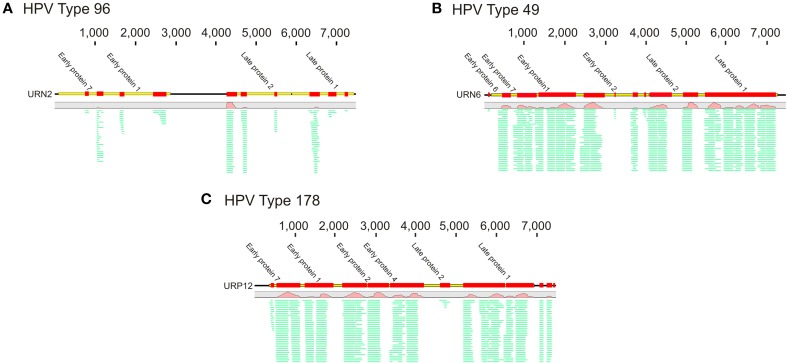
Read mappings of select viromes to Human papillomaviruses (HPVs). (A) Represents URN2 mapping to HPV Type 96, (B) represents URN6 mapping to HPV Type 49, and (C) represents URP12 mapping to HPV Type 178. The relative coverage of each contig is represented, along with annotated open reading frames (ORFs) above each box. The portions of the contigs identified are represented by the colored boxes for each subject. The length of each contig is denoted at the top of each panel. The relative proportions of reads mapping to each virus are represented in green.